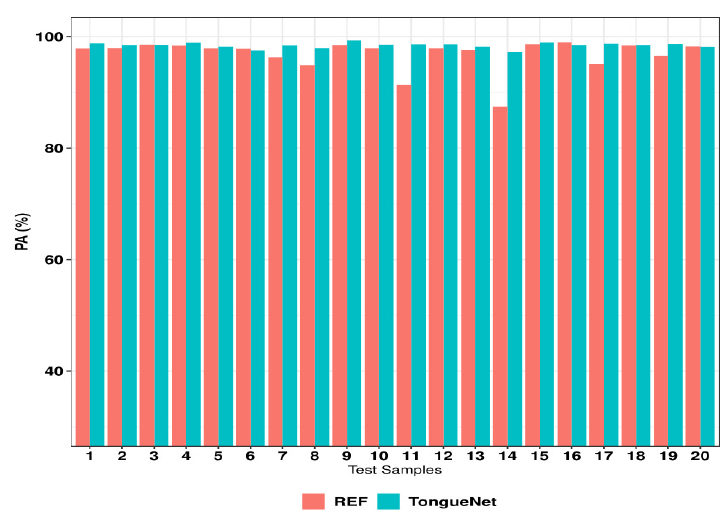
Figure 13. PA comparison of TongueNet (green) and REF (red).